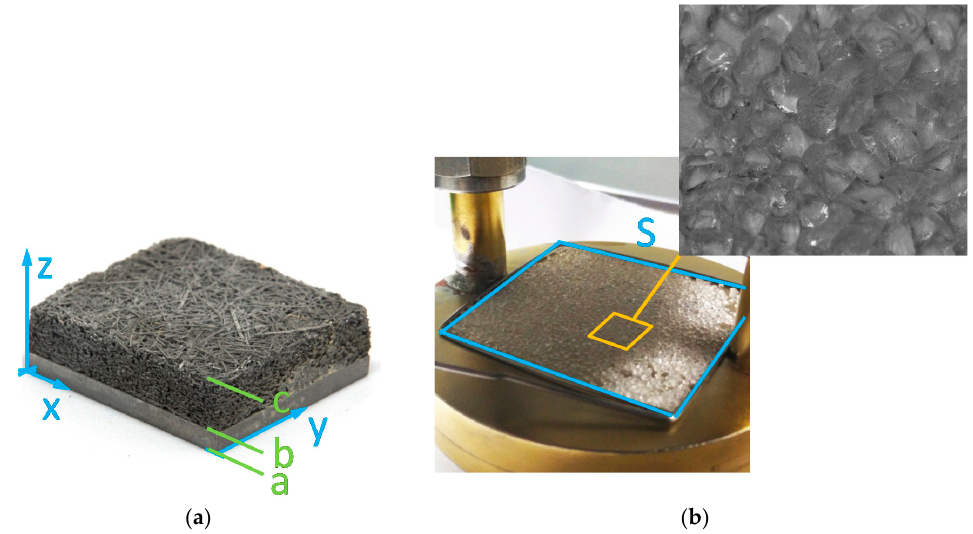
Figure 1. Pictures of sample 2_Fib ( a ) and 3_Sio ( b ) (Sio, Siogel). The area S is covered with Siogel grains in a monolayer configuration.